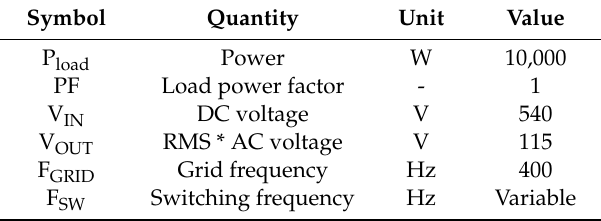
Table 1. Main input data of the studied converter. DC—direct current; AC—alternating